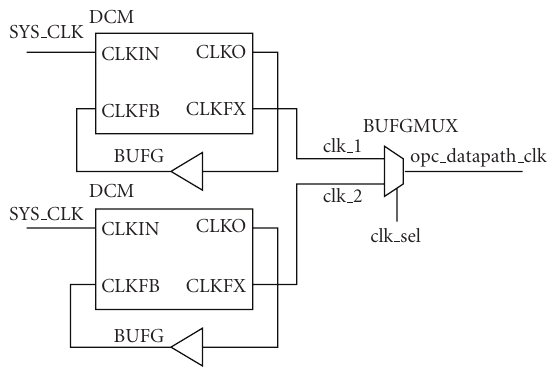
Figure 3: Example BUFGMUX /DCM